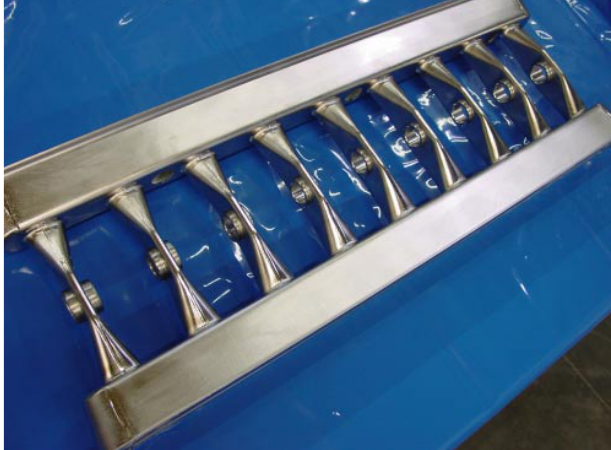
FIG. 20. (Color) Setup for the frequency and field tuning of the superconducting CH prototype. Ten movable tuners (top left) have been used to tune the